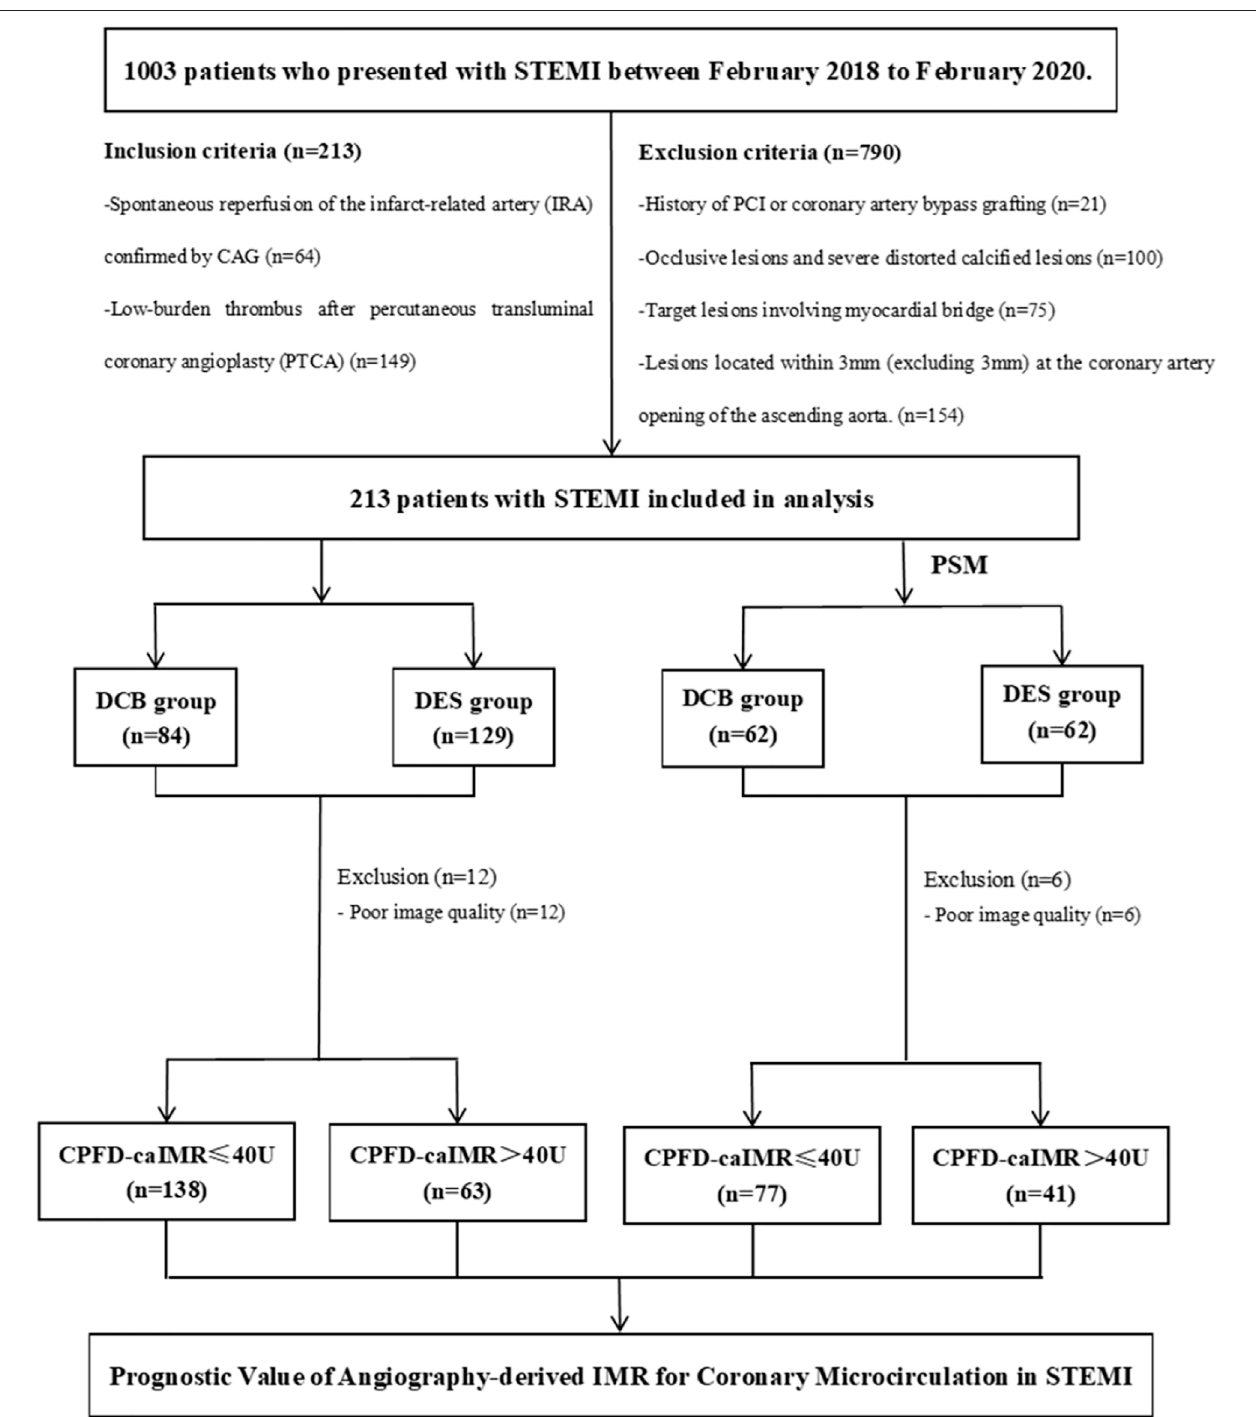
FIGURE 2 | The fl ow-chart of the study in detail. Abbreviations: STEMI, ST-segment elevation myocardial infarction; PCI, percutaneous coronary intervention; CPFD,computationalpressure- fl uiddynamics;caIMR,coronary-angiography-derivedindexofmicrocirculatoryresistance;DES,drug-elutingstents;DCB,drug-coated balloons; MACE, major adverse cardiovascular